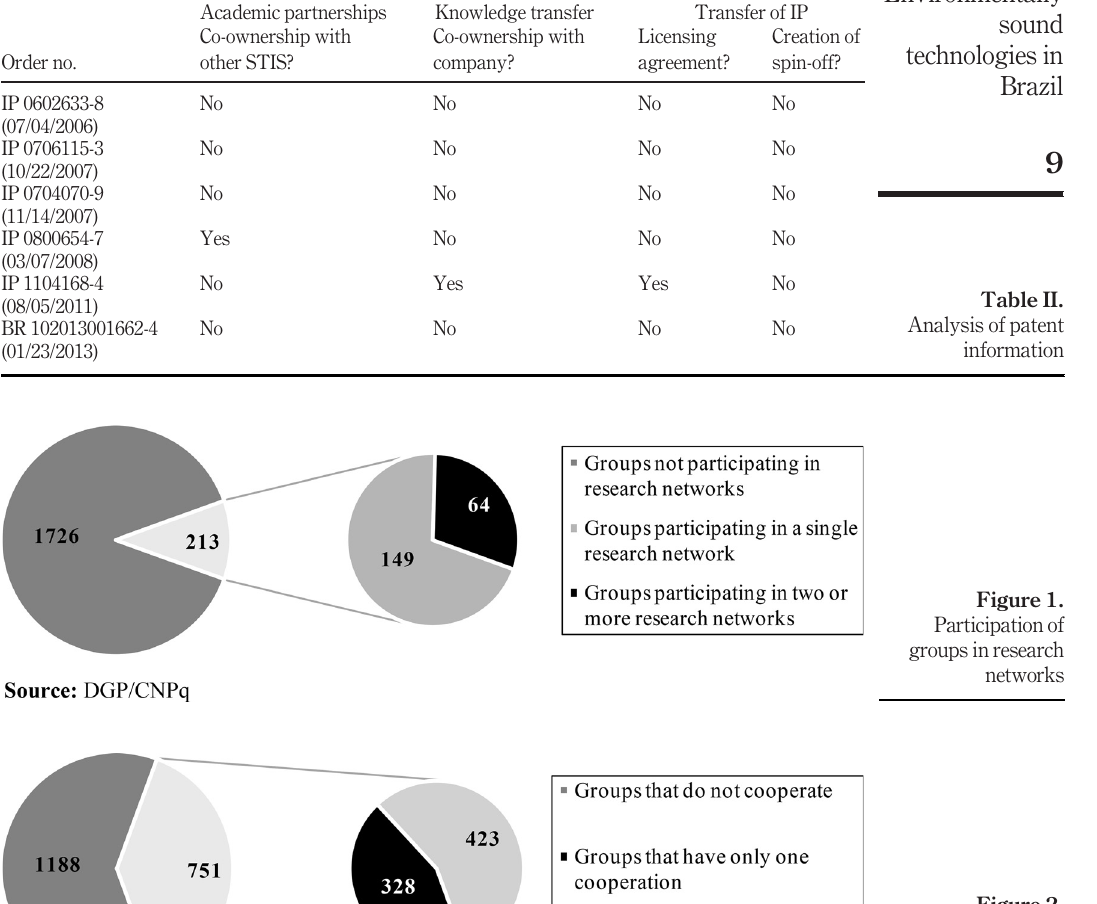
Figure 2. Scienti fi c and/or